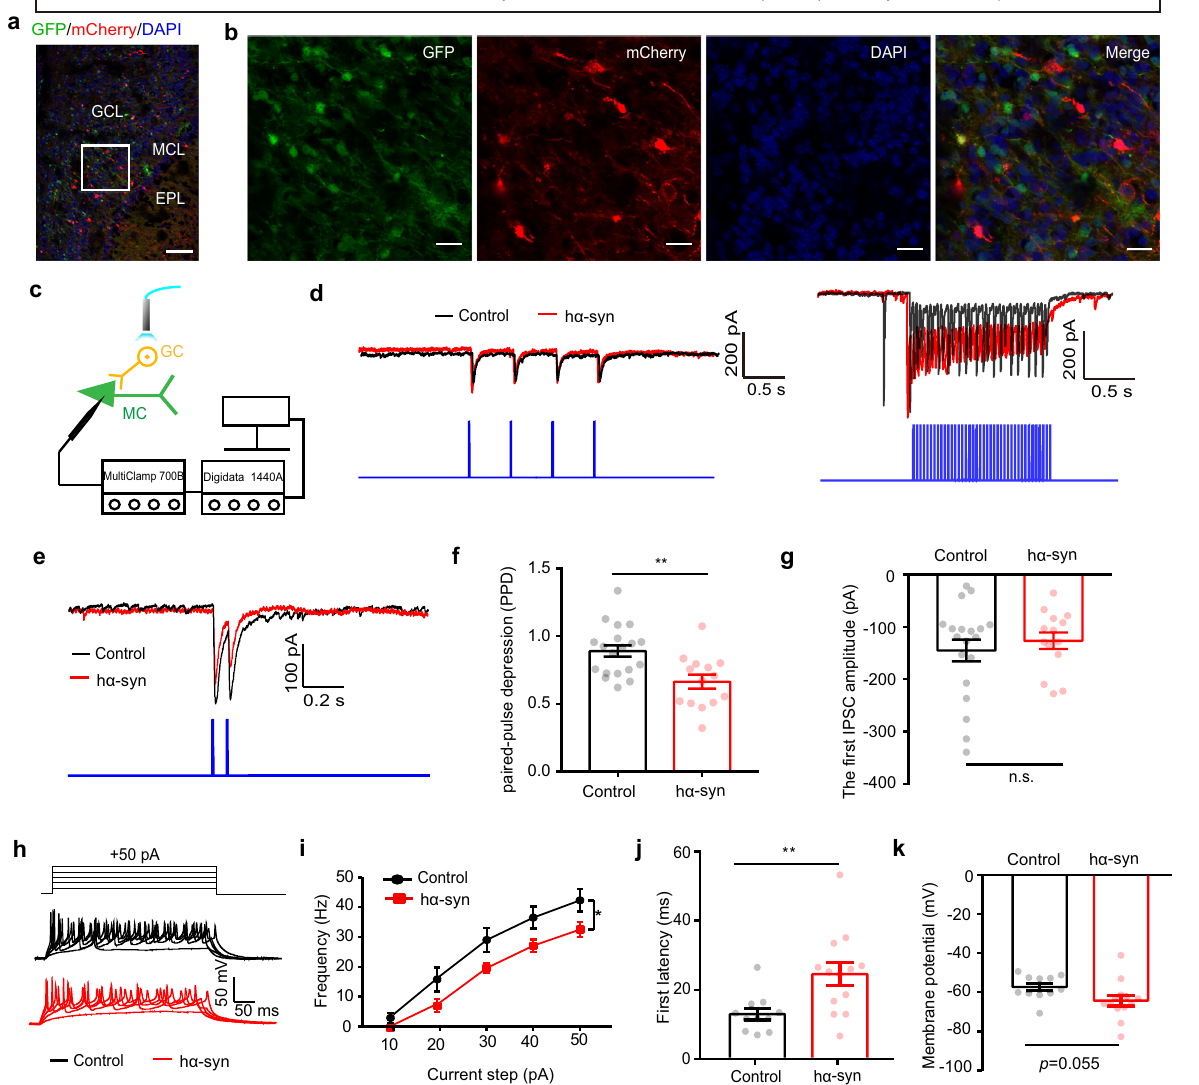
Fig. 6 α -Synuclein aggregates reduce paired-pulse depression of light-evoked IPSCs recorded from mitral cells and decrease granule cell activity in the OB. a , b Low-magni fi cation (scale bars = 100 μ m) ( a ) and high-magni fi cation (scale bars = 20 μ m) ( b ) images showing granule cells labeled with mCherry in the OB. EPL external plexiform layer, MCL mitral cell layer, GCL granule cell layer. c Schematic of the light-evoked IPSC electrophysiological recording. d Representative IPSCs recorded from mitral cells when 2 Hz (left) and 20 Hz (right) light illumination was applied. e Representative traces of paired-pulse IPSCs. f Quantitative analysis of the paired-pulse depression of light-evoked IPSCs recorded from mitral cells from the control and h α -syn groups (control: 19 cells from 8 mice; h α -syn: 14 cells from 6 mice). g Quantitative analysis of the amplitude of the fi rst light-evoked IPSC. h Representative current injection-evoked APs in granule cells. i – k Quantitative analysis of the frequency ( i ), onset latency ( j ), and membrane potential ( k ) elicited by positive current injections (13 cells from 5 mice for the control and h α - syn groups, respectively). mIPSC miniature inhibitory postsynaptic current; * p < 0.05; ** p < 0.01; n.s. not signi fi cant. Data are presented as mean ±